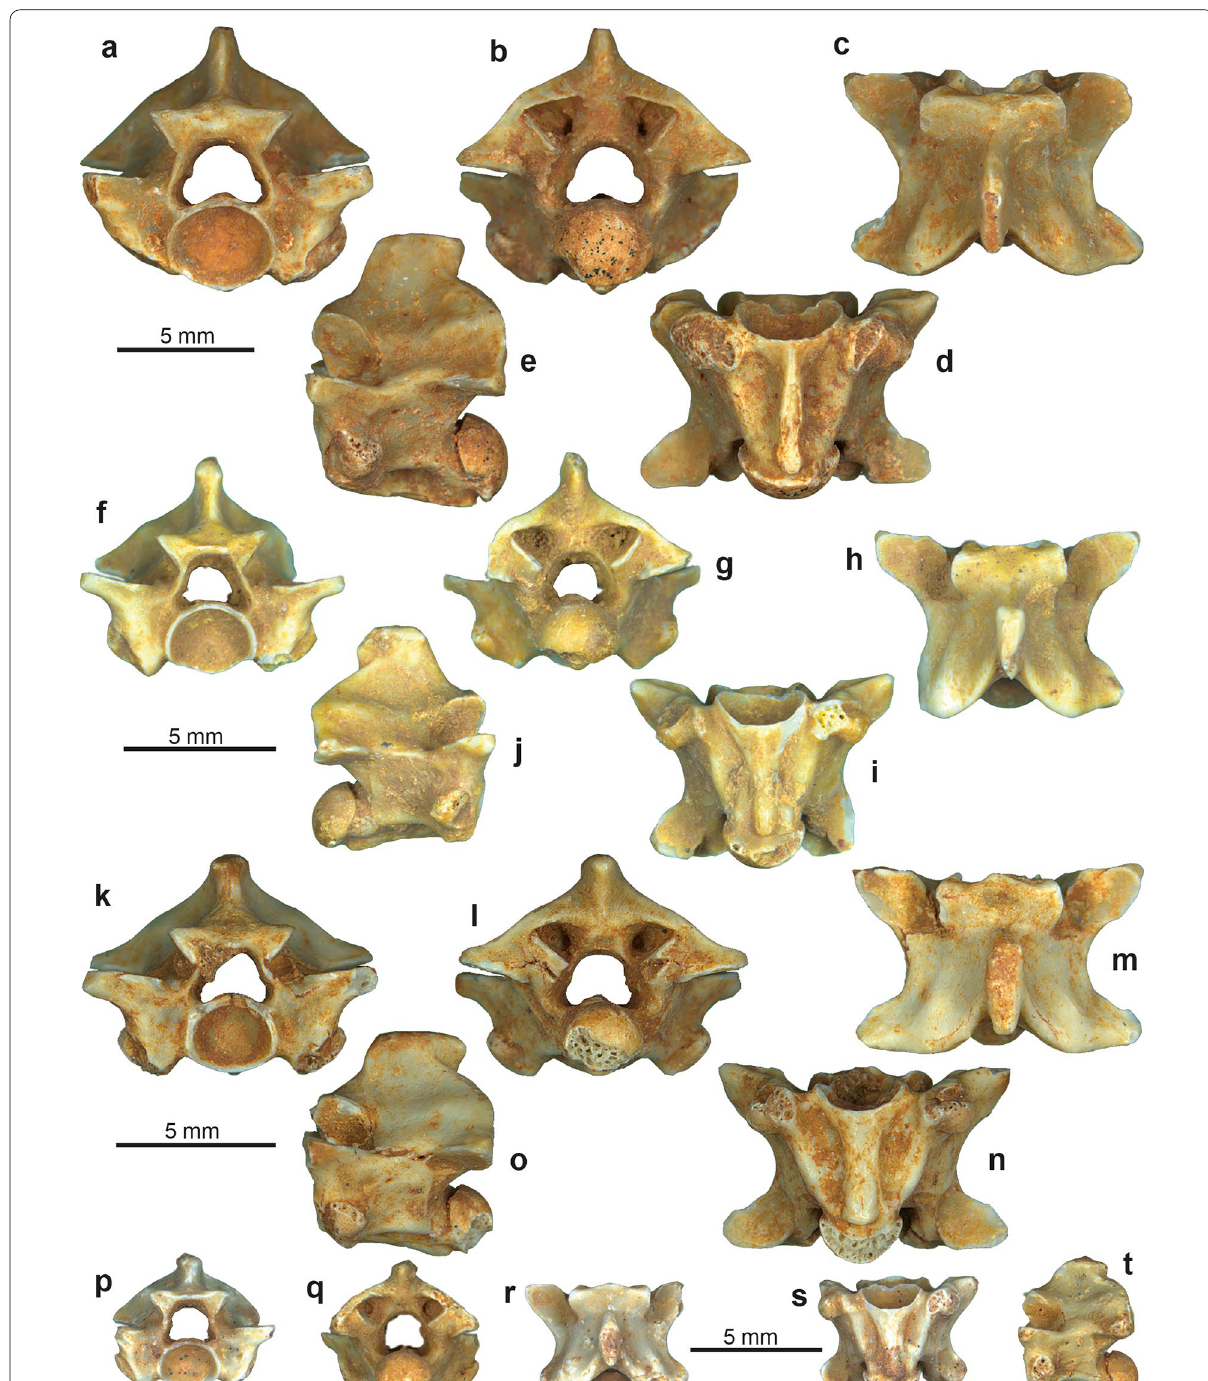
Fig. 45 “ Palaeopython ” neglectus from imprecisely known locality(ies) near Mouillac, Phosphorites du Quercy: a – e mid-trunk vertebra (YPM-VPPU 30363) in anterior ( a ), posterior ( b ), dorsal ( c ), ventral ( d ), and left lateral ( e ) views; f – j mid-trunk vertebra (YPM-VPPU 30362) in anterior ( f ), posterior ( g ), dorsal ( h ), ventral ( i ), and right lateral ( j ) views; k – o posterior trunk vertebra (YPM-VPPU 29858) in anterior ( k ), posterior ( l ), dorsal ( m ), ventral ( n ), and left lateral ( o ) views; p – t posterior trunk vertebra (YPM-VPPU 30367) in anterior ( p ), posterior ( q ), dorsal ( r ), ventral ( s ), and left lateral ( t )